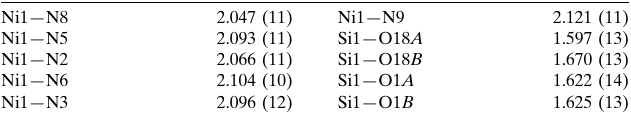
Selected bond lengths (A˚ ).